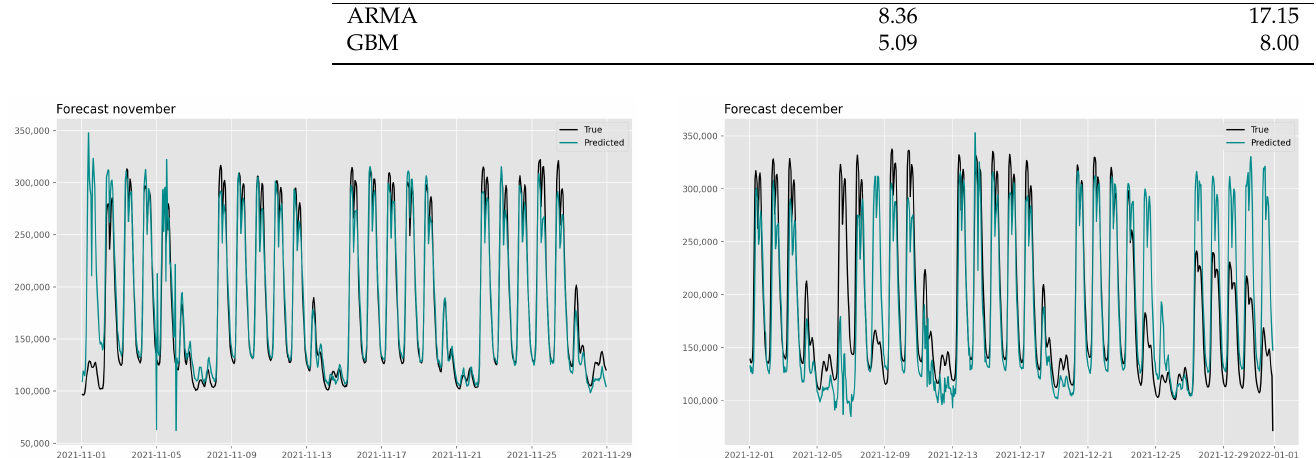
Figure 11. Forecasts using time series decomposition and ARMA model for November and